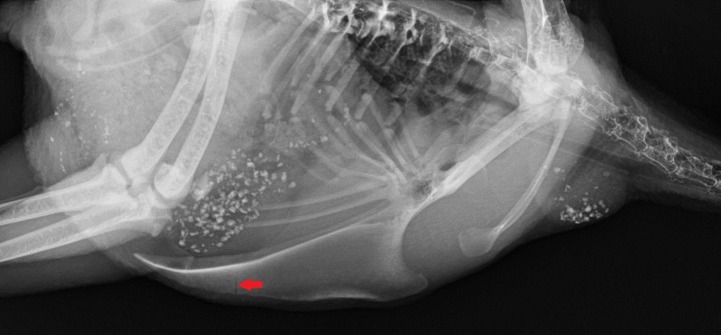
A fractured keel bone without callus formation.The arrow shows the fracture, a thin, black line.